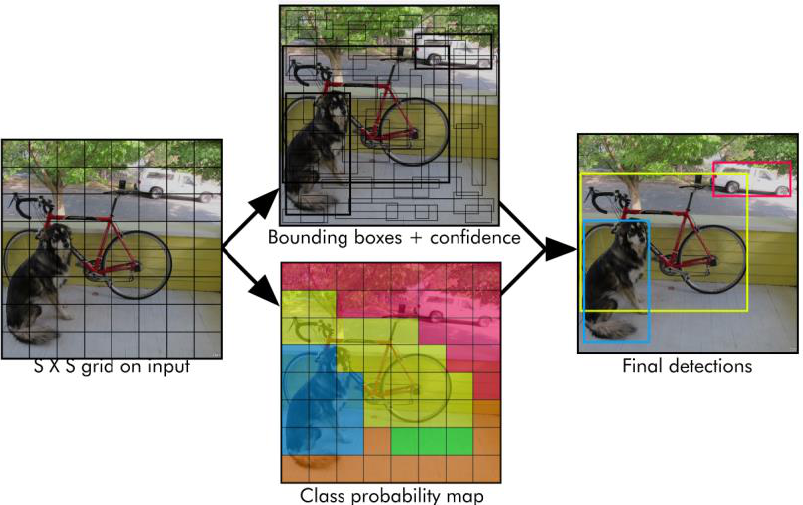
Figure 22. YOLO models the detection as a regression problem. It splits the image into an S × S grid and for each cell of the grid predicts bounding boxes B, confidence for those boxes (thicker lines, higher confidence) and class C probabilities. These predictions are encoded as a tensor S × S × (B ∗ 5 + C) (Adapted from [31,32]).